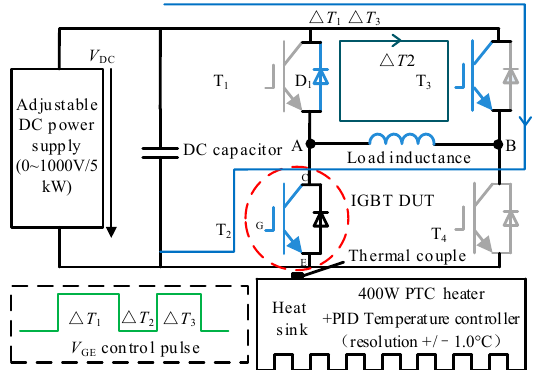
Figure 5. Schematic of the IGBT double-pulse test rig.